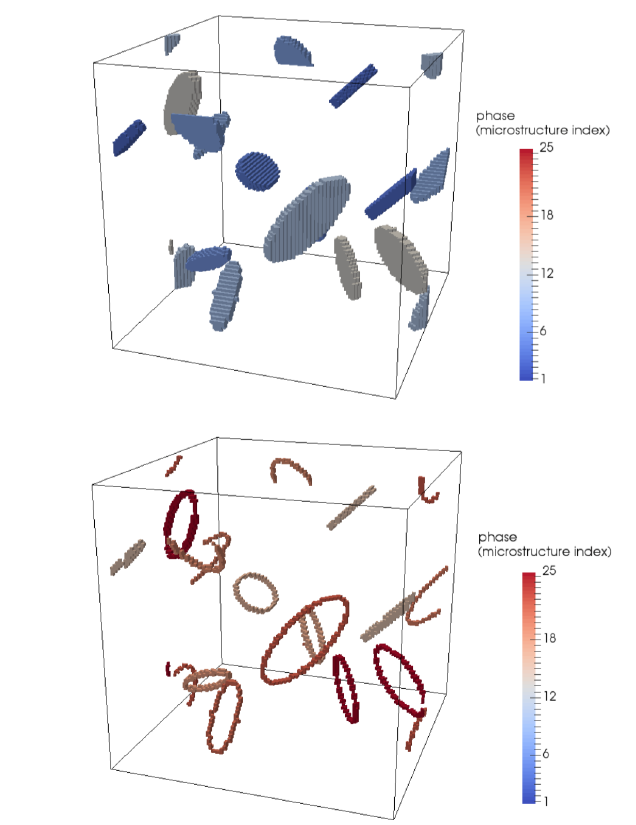
Figure 2. Here, the inner of a dislocation and the dislocation line are shown separately. top: the microstructure index 2–13 refers to the inner of dislocations, bottom: the microstructure index 14–25 refers to dislocation loops. Microstructure index 1 refers to the matrix and is not